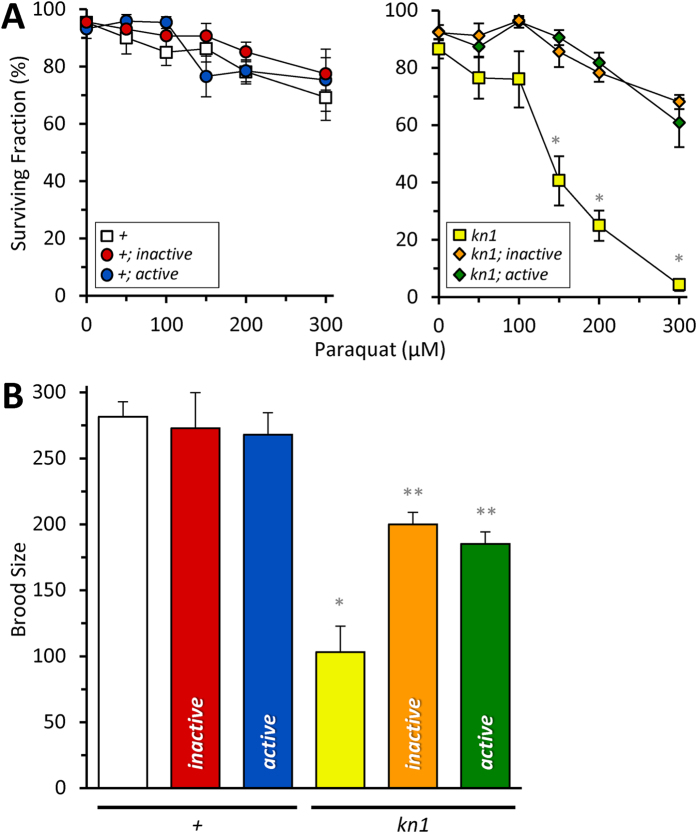
Complementation of mev-1(kn1)III mutant phenotypes with a transgenic mev-1(+)::miniSOG single copy insert.The mev-1::miniSOG fusion was expressed as a MosSCI single-copy transgene in trans to the wild-type or mutant mev-1 on chromosome II, and strains that were homozygous for both mev-1 loci were used to assess: (A) 96-hour survival as a function of cultivation on plates containing from 0–300 μM paraquat, as shown. Data from wildtype and kn1 backgrounds are plotted on separate axes for clarity. Data are mean ± SEM. N = 4–22. An “N” is considered an independent trial of >50 worms. *Adjusted P < 0.01 vs all other groups (2-way ANOVA with Tukey multiple comparisons test). (B) Brood size, as represented by the number of viable progeny produced from staged L4 larval worms followed over the course of ten days. Data are mean ± SEM. N = 4–7. An “N” is considered an independent trial of up to 5 worms. *Adjusted P < 0.01 vs wild-type (+) and **Adjusted P < 0.05 vs wild-type (+) and kn1 (1-way ANOVA with TUKEY multiple comparisons test). Alleles are abbreviated as outlined in Fig. 1.